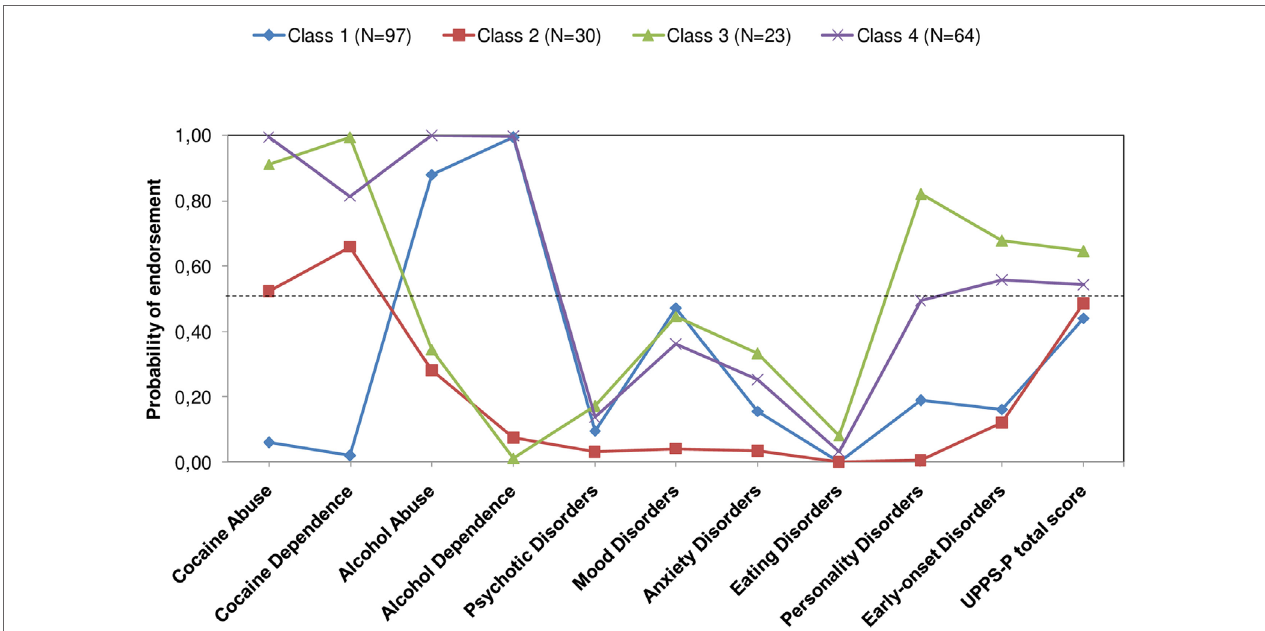
FigUre 1 | Test performance of LCA-derived analysis. LCA revealed four LCs underlying sample data, with different clinical profiles according to the probability of showing lifetime diagnoses of substance use disorders, comorbid mental disorders, and high impulsivity scores in the UPPS-P scale. Abbreviations: BIC,